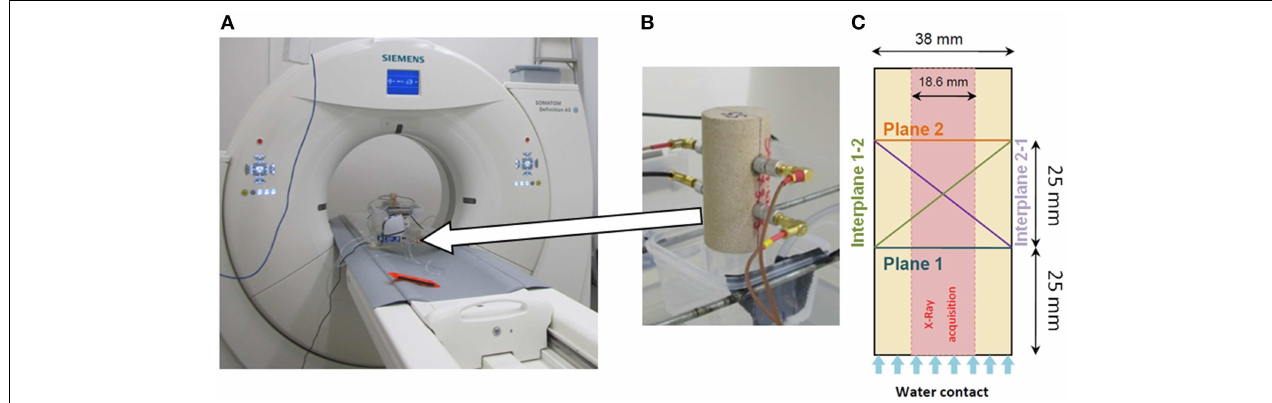
FIGURE 7 | Experimental device used for imbibition tests coupling ultrasonic measurements with X-ray imaging. (A) X-ray CT scanner. (B) Sample on the water tank with four sensors glued on the lateral surface. (C) Scheme of the equipped sample: studied ray paths for